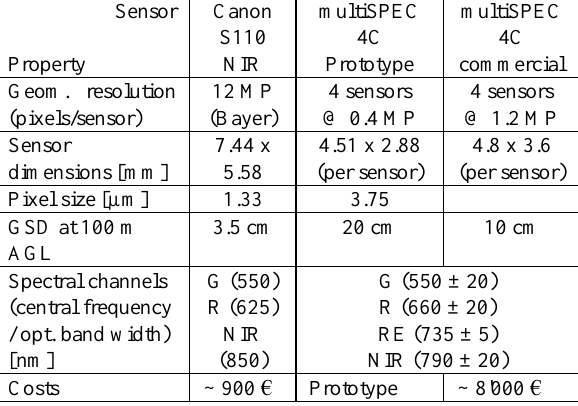
Table 2. Overview of investigated UAV multispectral